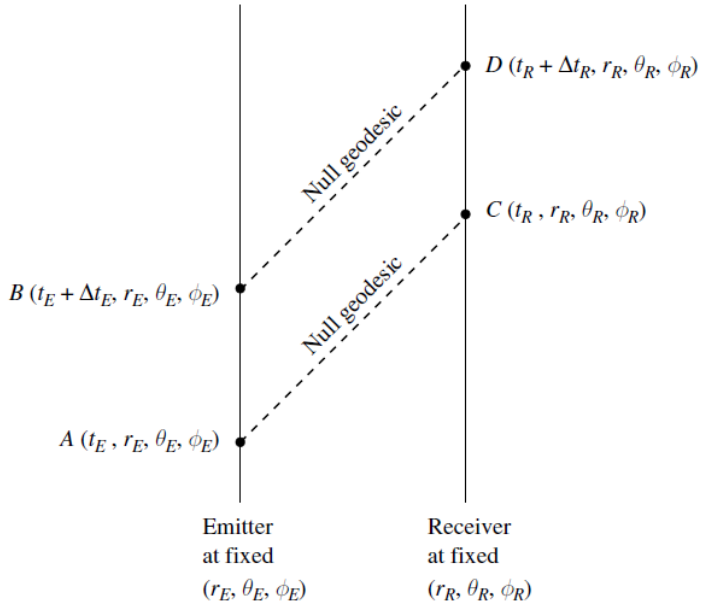
Figure A2. Diagram showing two null (photon) geodesics. In our case where the photons are emitted radially, we have θ E = θ R and φ E = φ R . Adapted from